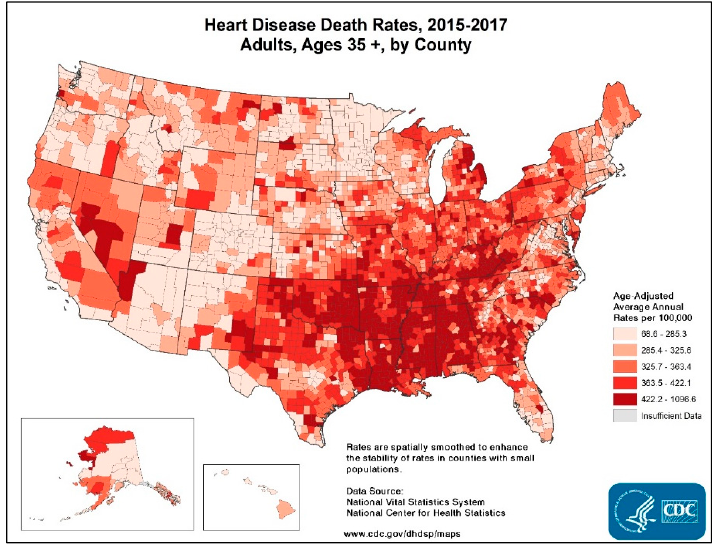
Figure 6. Example of atlas maps of heart disease and stroke produced by the Center for Disease Control and Prevention (CDC). (Source: [18]).